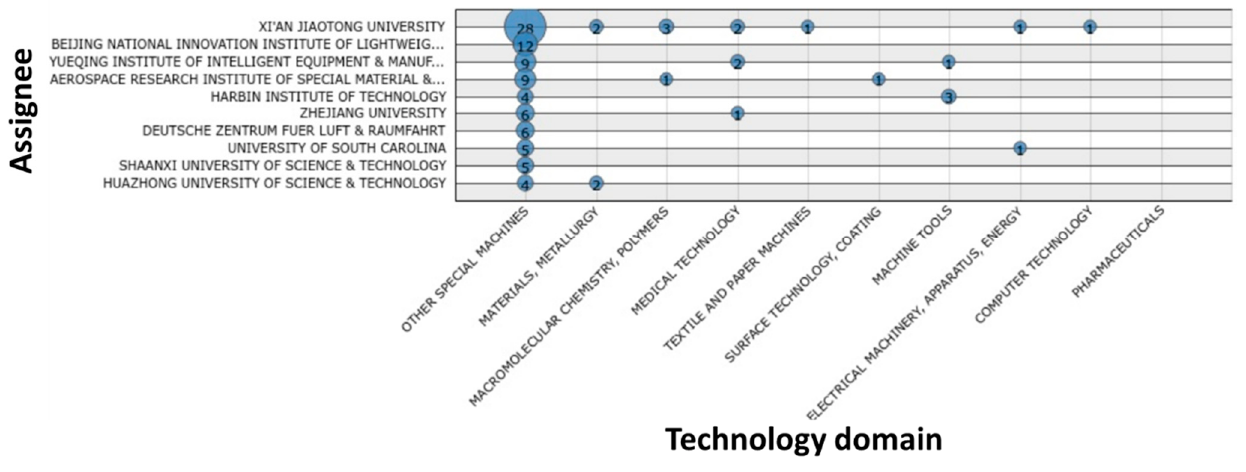
Figure 17. Main technology domains covered by the 10 largest institutional assignees in FFF adapted to CFRTPC printing in February 2021.